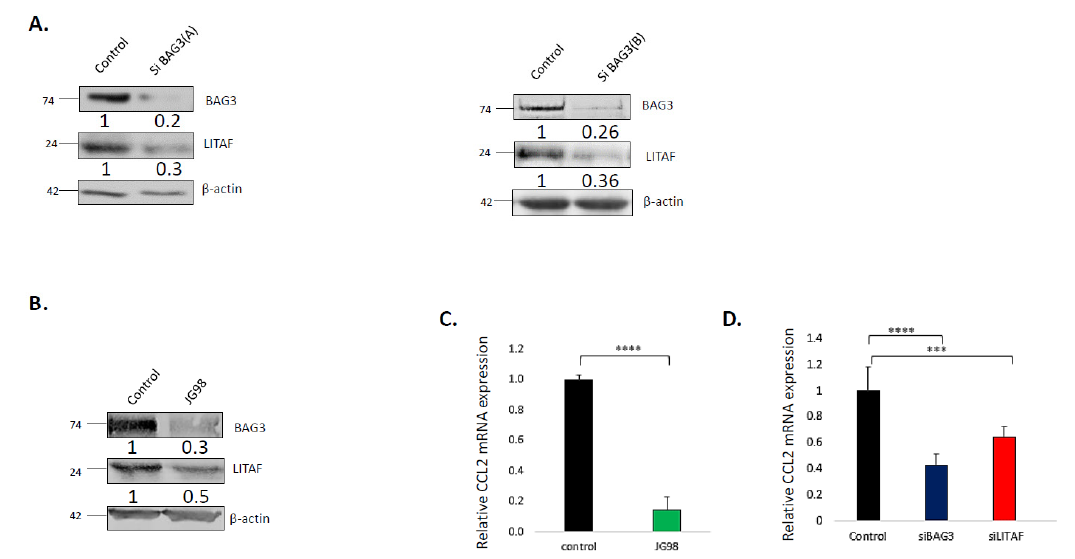
Figure 1. Effect of BAG3 on LITAF expression and activity. ( A ) Silencing of Bag3 downregulates LITAF. Differentiated THP1 macrophages were transfected with BAG3 or control siRNAs, as indicated. After 72 h, levels of indicated proteins were detected by immunoblot analysis. ( B ) Inhibition of Hsp70 leads to downregulation of LITAF. Cells were treated with 5 µ M JG98 or left untreated. After 24 h, levels of indicated proteins were detected by immunoblot analysis. Numbers under the blot lanes represent relative expression normalized to β -actin. ( C ) Silencing of Bag3 causes downregulation of the LITAF target gene CCL2. THP1 cells were transfected with indicated siRNAs for 72 h followed by real-time PCR analysis of CCl2 mRNA levels. ( D ) Inhibition of Hsp70 causes downregulation of CCL2. THP1 cells were treated with 5 µ M JG98 for 24 h followed by real-time PCR analysis of CCl2 mRNA levels using a two-sample t -test. Depicted is the mean relative expression (log2) ± s.e.m. *** p ≤ 0.001 and **** p ≤ 0.0001. Uncropped WB Figure S1#.